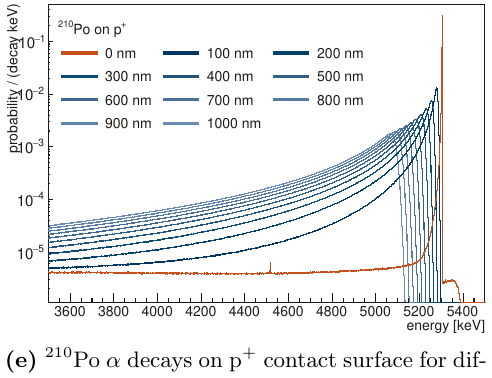
(e) 210 Po (cid:11) decays on p + contact surface for dif- ferent thicknesses of the inactive contact layer. For 0 nm the nuclear recoil energy can be ab- sorbed and some energy can be lost in the LAr.